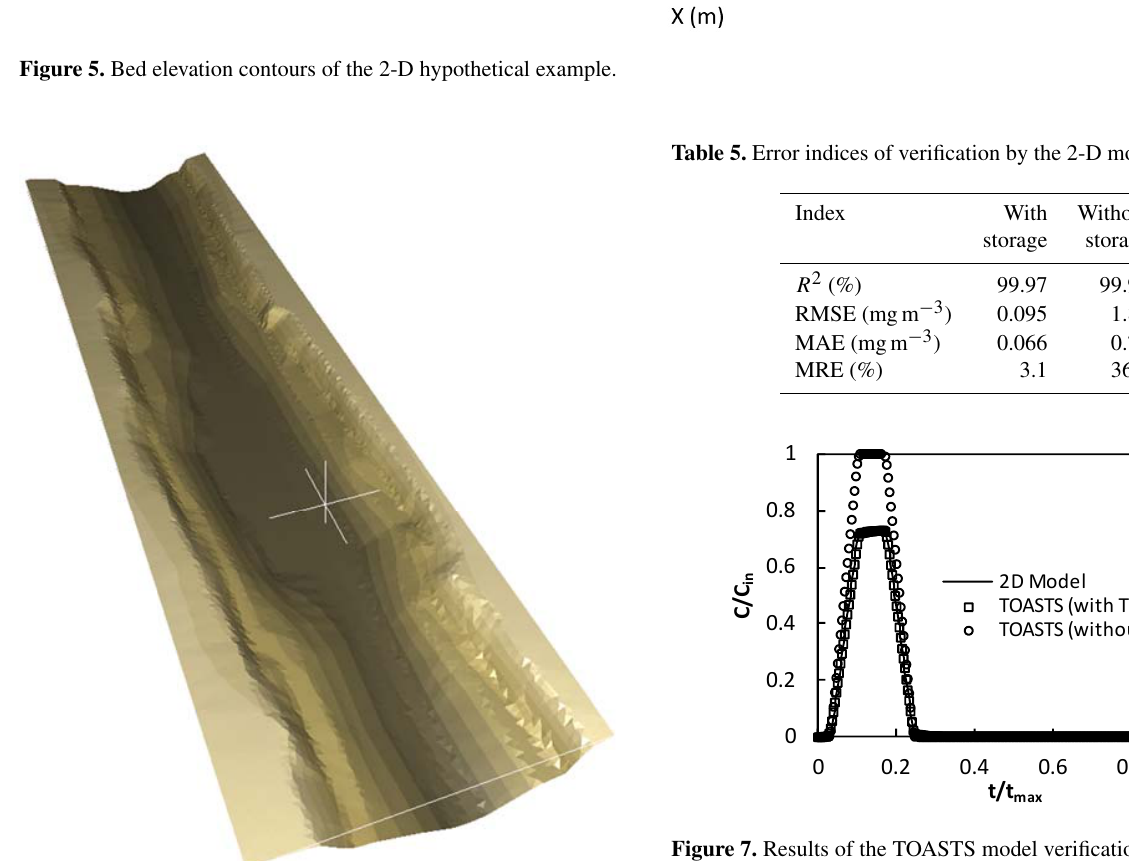
Figure 7. Results of the TOASTS model verification using the 2-D